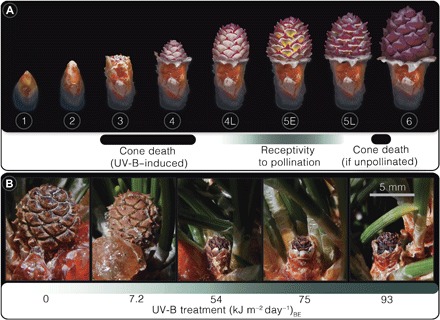
Ovulate cone developmental stages in (P. mugo).(A) Schematic of ovulate cone developmental stages in P. mugo. Stage descriptions: (1 to 2) Bud enclosing cone expands. (3) Cone emergence from bud scales. (4) Cone extends. (4L) Extension is completed, but ovuliferous scales (purple) are not fully opened. (5E) Ovuliferous scales perpendicular to cone axis—enabling pollen access to ovules. (5L) Ovuliferous scales swell, intercepting pollination. (6) Ovuliferous scales swollen completely, blocking pollen access to ovules (63). (B) Images of select ovulate cones from each treatment showing a typical developmental stage ~70 to 76 days following emergence. Treatments correspond to growth chamber control (0), outdoor ambient (7.2), and end-Permian modeled (54, 75, and 93) UV-B regimes. See Supplementary Text for details.